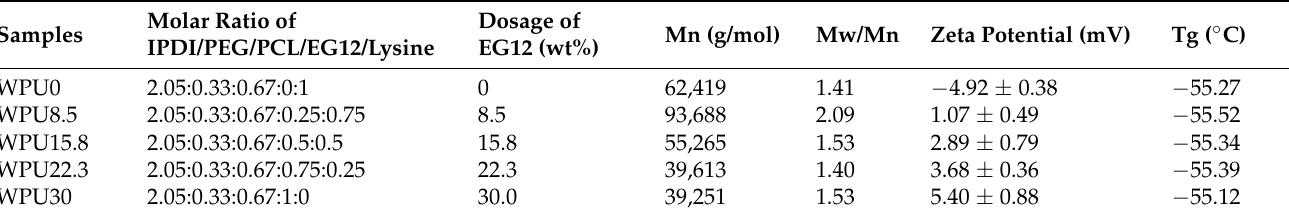
Table 1. The theoretical composition, molecular weight, Zeta potential, and glass transition tempera- ture (Tgs) of WPUn